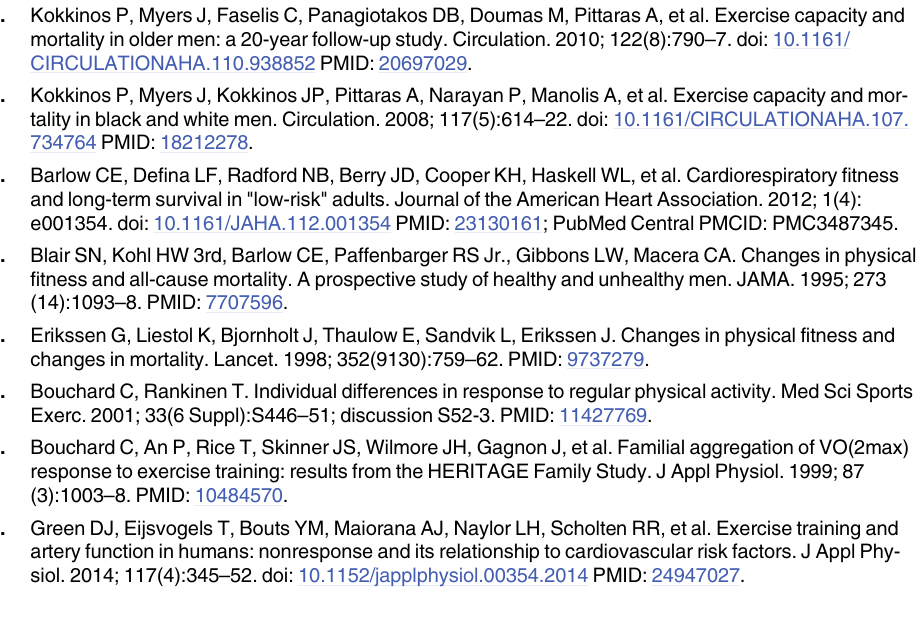
S1 Fig. Genome-wide scans for pre-training (A), post-training (B), and change in exercise time (C) in combined crosses. Scans were performed on z-score transformed phenotypes for the entire population with “ sex ” and “ cross ” as additive covariates. FVB and 129S1 strains were coded as high and B6 and NZW strains as low. Horizontal lines represent significant (P = 0.05) and suggestive (P = 0.63) logarithm of odds (LOD) thresholds, respectively. LOD thresholds were determined by permutation testing using 1000 permutations. (TIFF) S2 Fig. Genome-wide scans for pre-training (A), post-training (B), and change in exercise time (C) after re-coding combined crosses. Scans were performed on z-score transformed phenotypes for the entire population with “ sex ” and “ cross ” as additive covariates. FVB and NZW strains were coded as low and B6 and 129S1 strains as high. Horizontal lines represent significant (P = 0.05) and suggestive (P = 0.63) logarithm of odds (LOD) thresholds, respec- tively. LOD thresholds were determined by permutation testing using 1000 permutations.